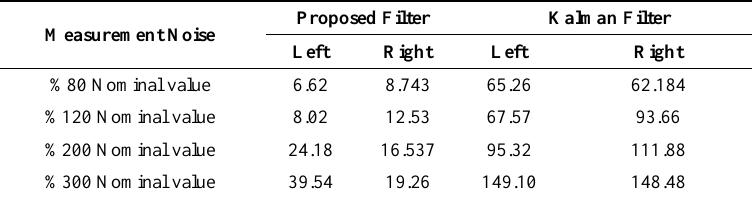
Table 1. Consideration of the efficiency of Kalman filter in first scenario